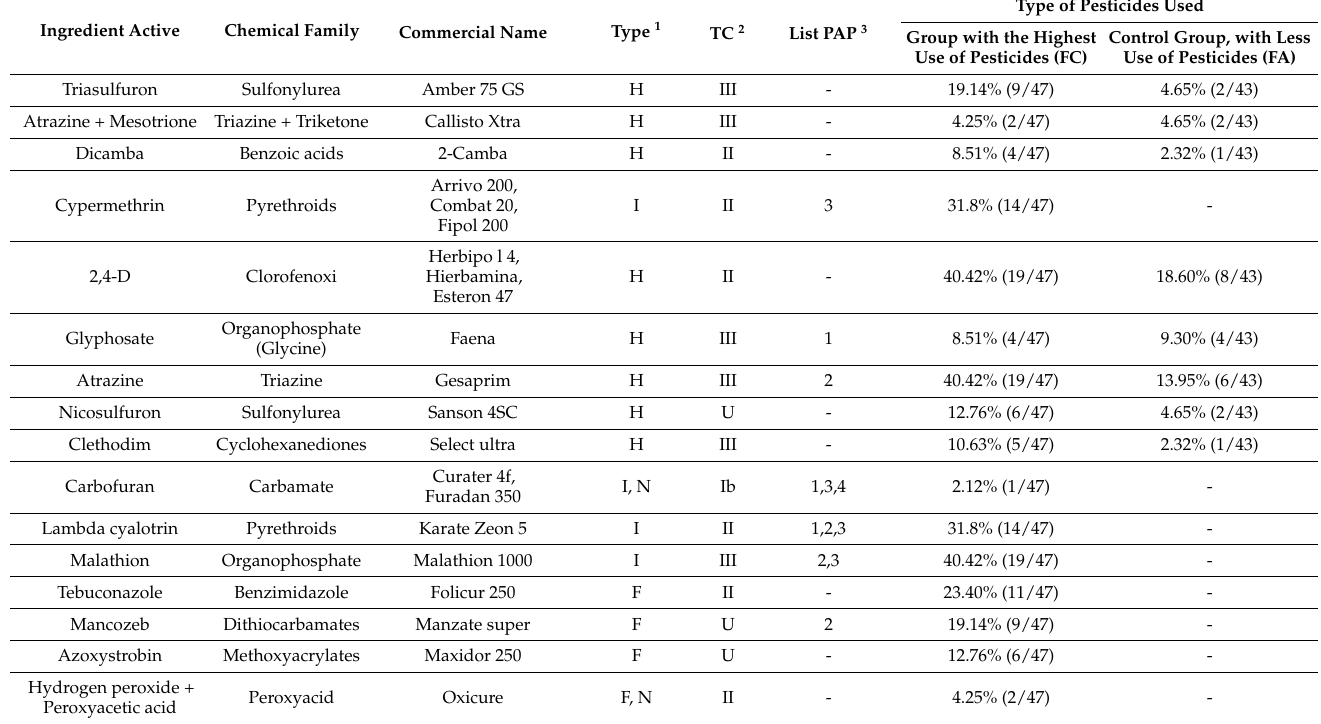
Table 2. Pesticides used by peasant maize producers in the municipality of Vicente Guerrero, Tlaxcala,